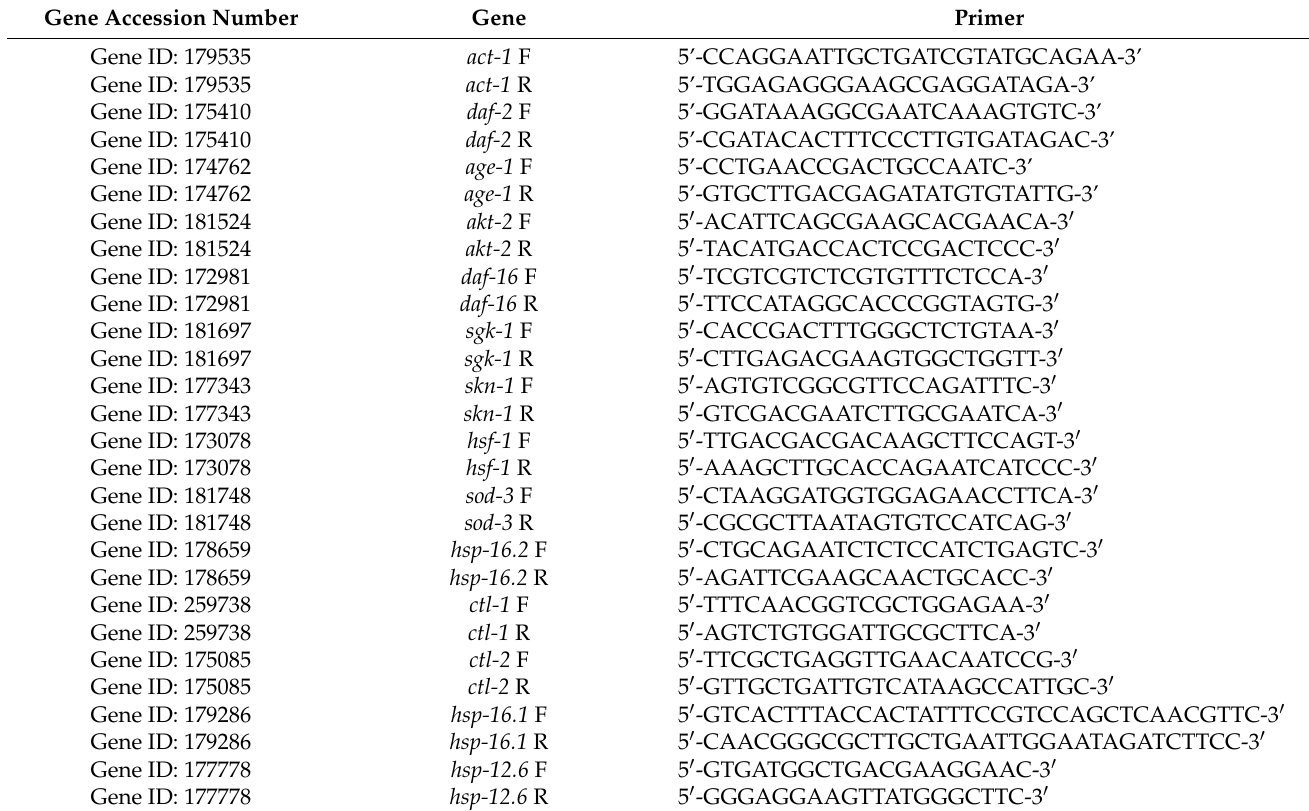
Table 1. Primer sequences of genes used in the